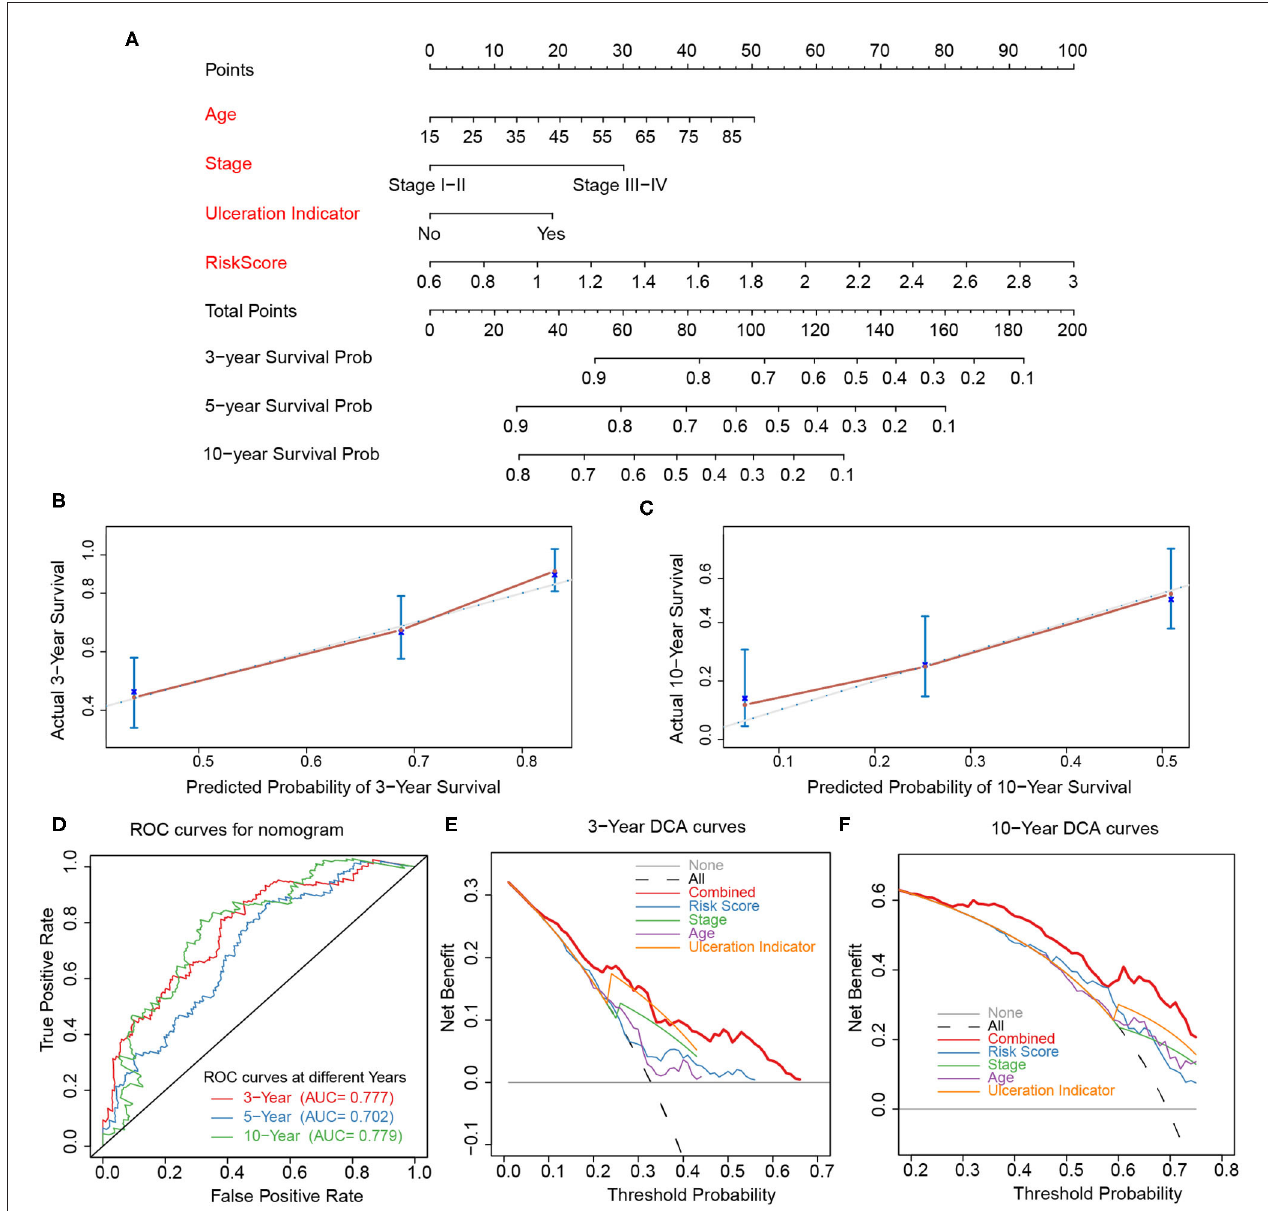
FIGURE 7 | Construction and validation of nomogram. (A) Nomogram constructed based on age, stage, ulceration indicator, and risk score as predictive factors to predict 3-, 5-, 10-year survival probability. (B,C) Calibration curves for the survival probability at 3 and 10 years. (D) ROC curves for 3-, 5-, 10-year prediction of the nomogram. (E,F) DCA curves to evaluate the clinical utility of different decision strategies, and the red line represented the combined nomogram.